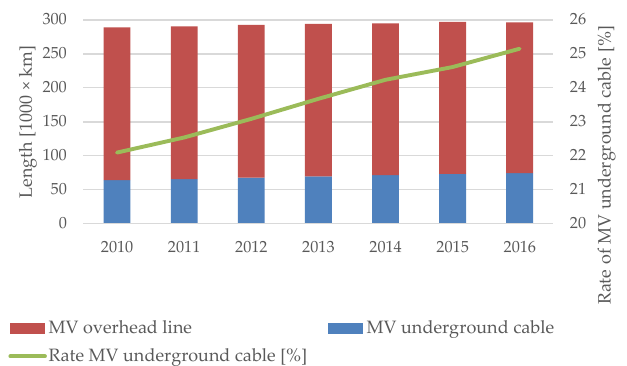
Figure 2. Share of MV cable lines in MV networks in 2010–2016 in Poland [4].